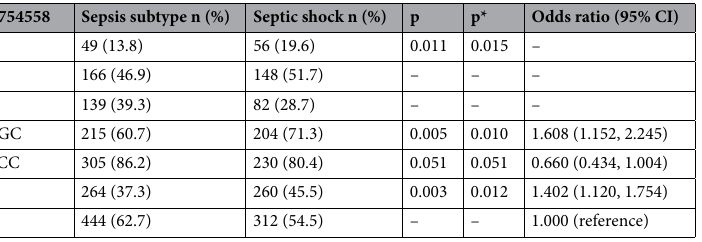
Table 3. Genotype and allele frequencies distribution of the NLRP3 rs10754558 in the different sepsis status. 95% CI 95% confidence interval. *False discovery rate-adjusted p-value for multiple hypotheses testing using the Benjamini–Hochberg method.